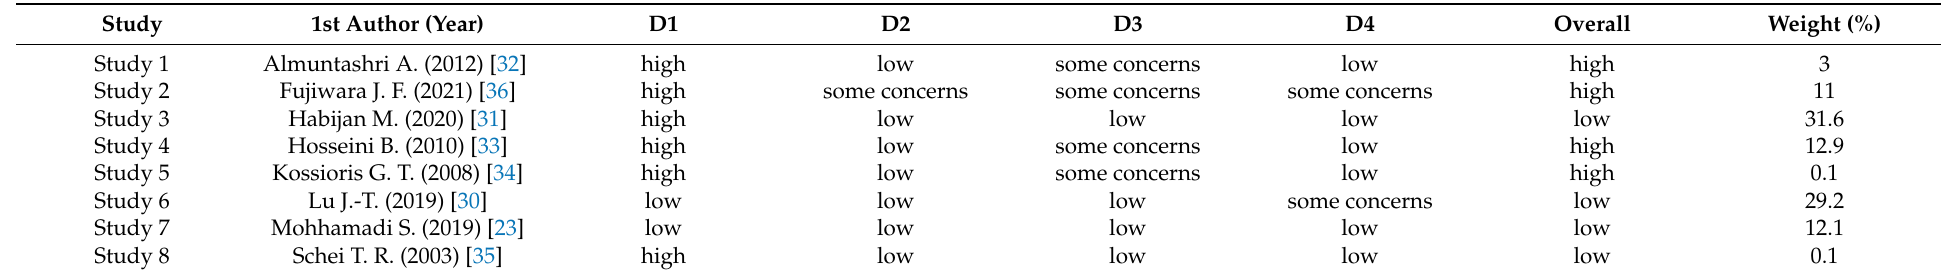
Table A3. Risk of